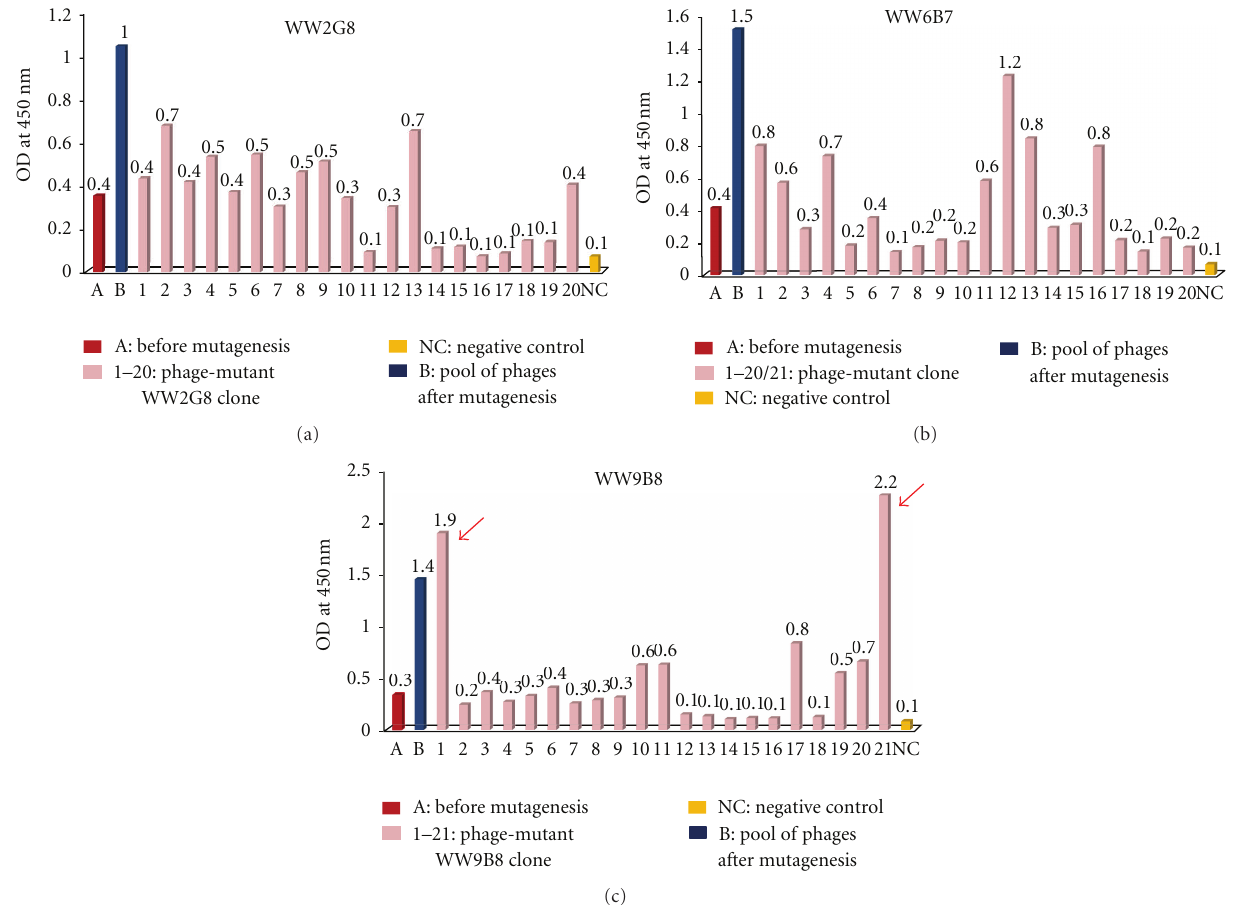
Figure 4: Isolation of individual mutant clones carrying improved binding activities of phages displaying anti-MICA. Individual clones (10 8 pfu) isolated from the 7th round of biopanning were tested for MICA binding by ELISA. WW2G8, WW6B7, and WW9B8 mutants were shown in (a), (b), and (c), respectively. VCSM13 (10 8 pfu) was used as a negative control. It should be noted that most of isolated clones had OD less than the pool phages with the exception of WW9B8. There were two WW9B8 mutants (red arrow) with OD values of 6 and 7 times higher than that of the pool phages,